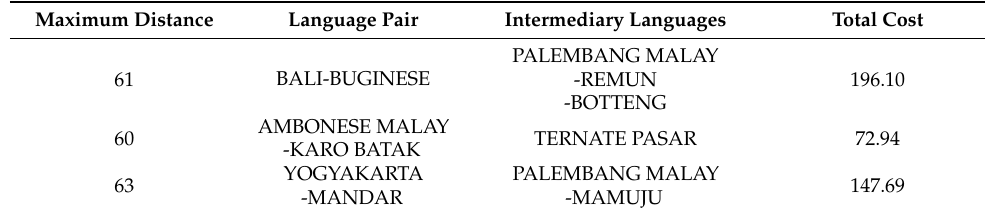
Table 5. Total Cost using Yen’s K Algorithm with K = 1.